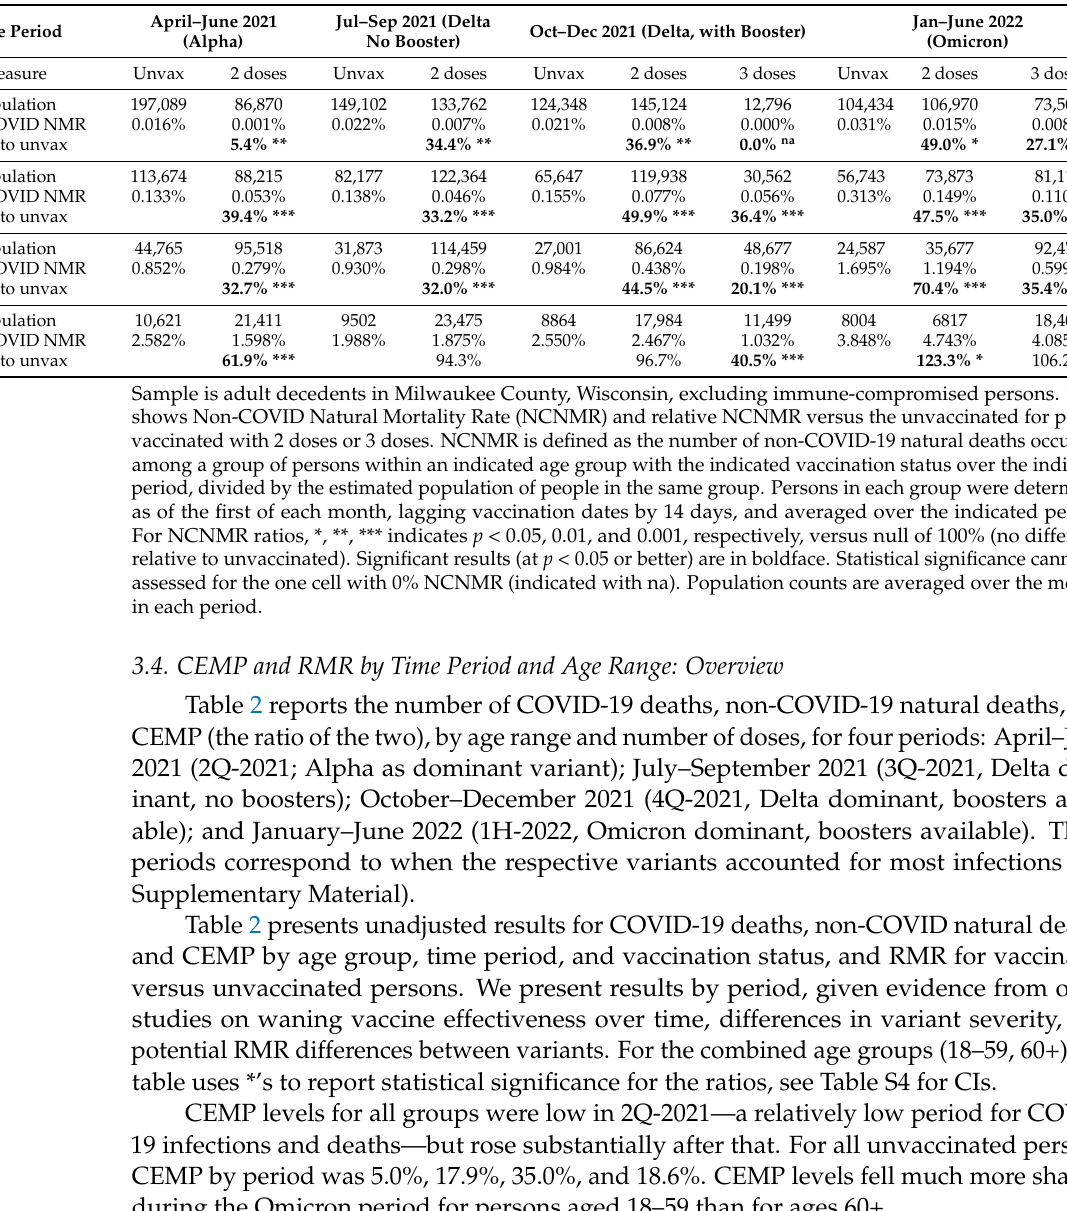
Table 1. Non-COVID Natural Mortality Rate (non-COVID-NMR) by Age Group and Time